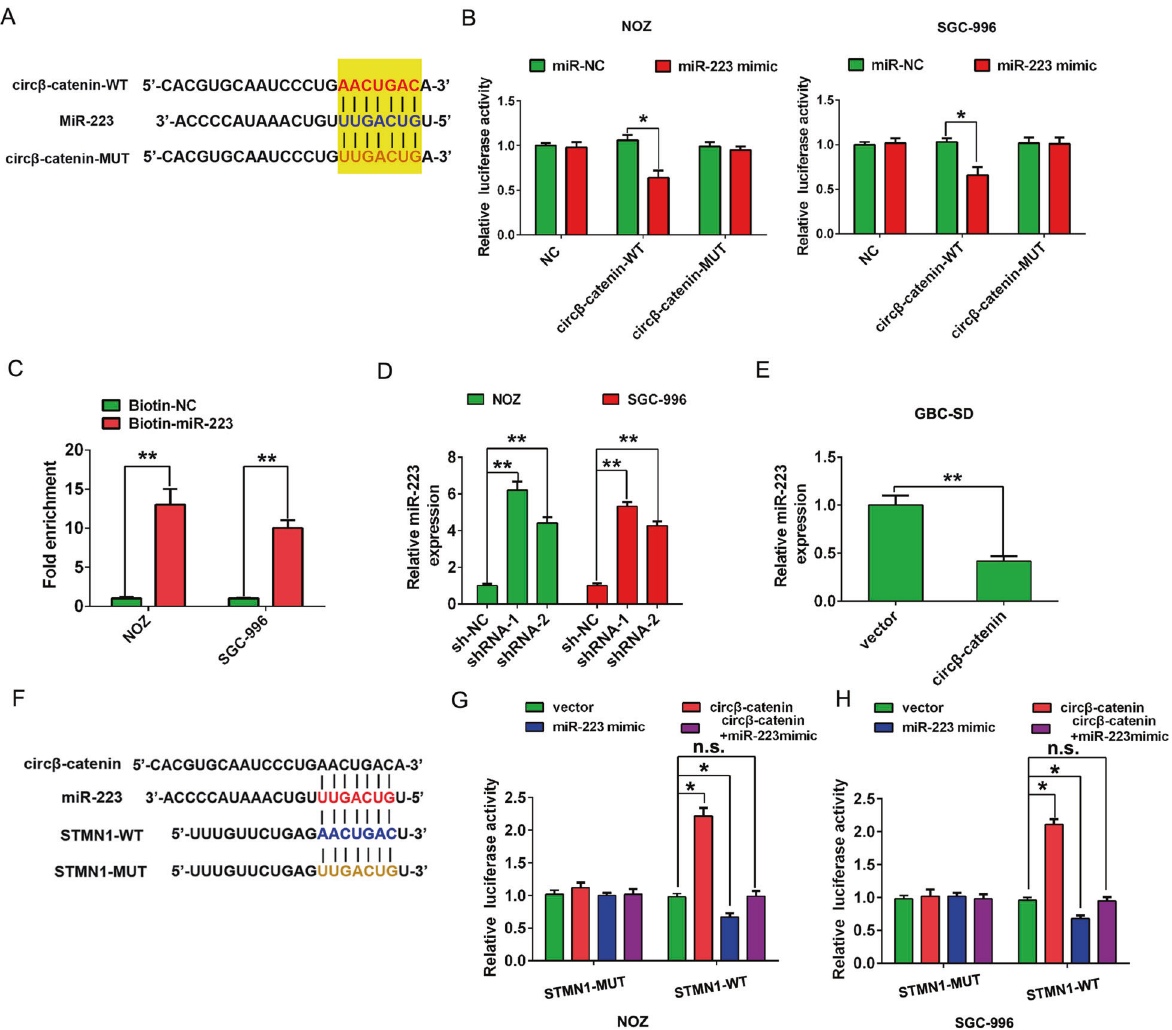
Fig. 5 circ β -catenin targets miR-223/STMN1 in GBC cells. A MiR-223 showed complementary base pairing with circ β -catenin using the online software tools circinteractome (http://circinteractome.nia.nih.gov). B Luciferase reporter assay illustrated the correlation within circ β -catenin-WT and miR-223. C 3 ′ -terminal-biotinylated-miR-223 probe that was veri fi ed to pull down circ β -catenin in NOZ and SGC-996 cells. D , E The miR-223 expression was detected by qRT-PCR after transfection of NOZ and SGC-996 cells with shRNA-NC, shRNA-1, or shRNA-2, or after transfection of GBC-SD cells with pLCDH-vector or pLCDH-circ β -catenin. F The WT and corresponding MUT of the STMN1 mRNA 3 ′ UTR were constructed targeting miR-223. G , H Luciferase reporter assays were performed in NOZ and SGC-996 cells transfected with pLCDH-vector, pLCDH-circ β -catenin, miR-223 mimic, or co-transfected with miR-223 mimic + pLCDH-circ β -catenin and STMN1-WT or STMN1-MUT reporter vector. Data are shown as mean ± SD. * P < 0.05. ** P < 0.01. n.s., not signi fi